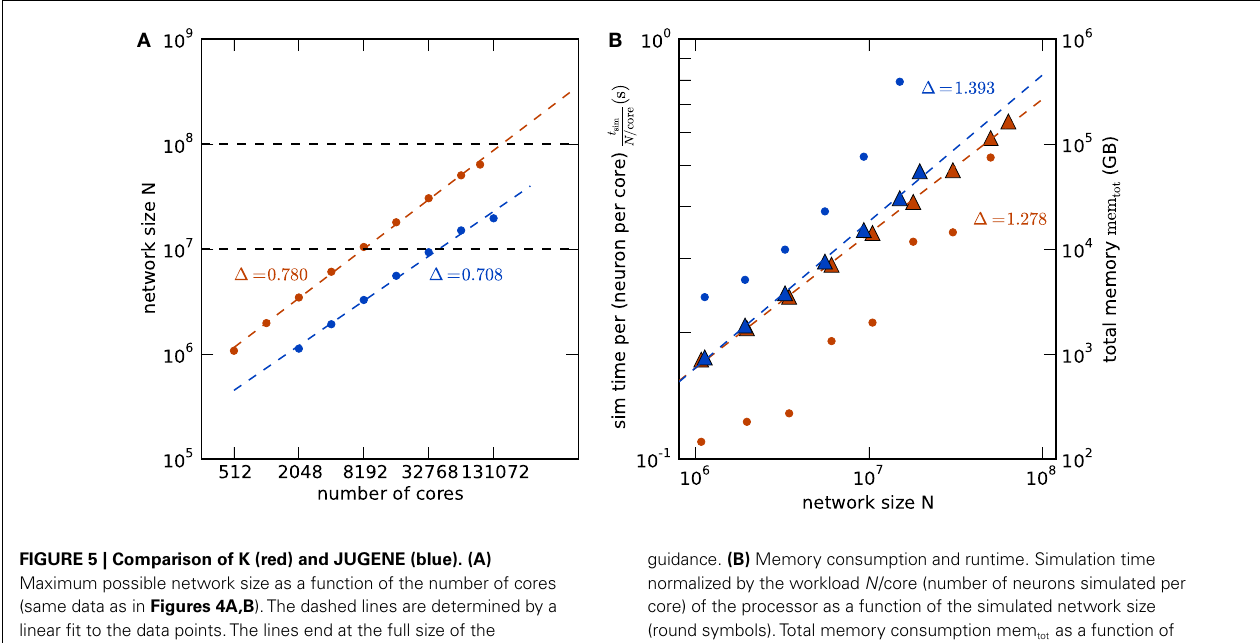
FIGURE 5 | Comparison of K (red) and JUGENE (blue). (A) Maximum possible network size as a function of the number of cores (same data as in Figures 4A,B ).The dashed lines are determined by a linear fit to the data points.The lines end at the full size of the respective machine (294,912 cores for JUGENE, 705,024 cores for K). The dashed horizontal lines at 10 7 and 10 8 neurons are given for visual